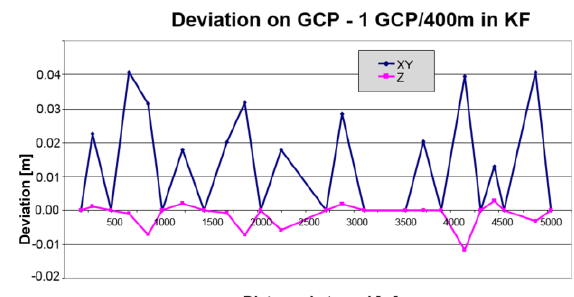
Figure 6: Deviation on GCPs using GCPS every 400m for KF